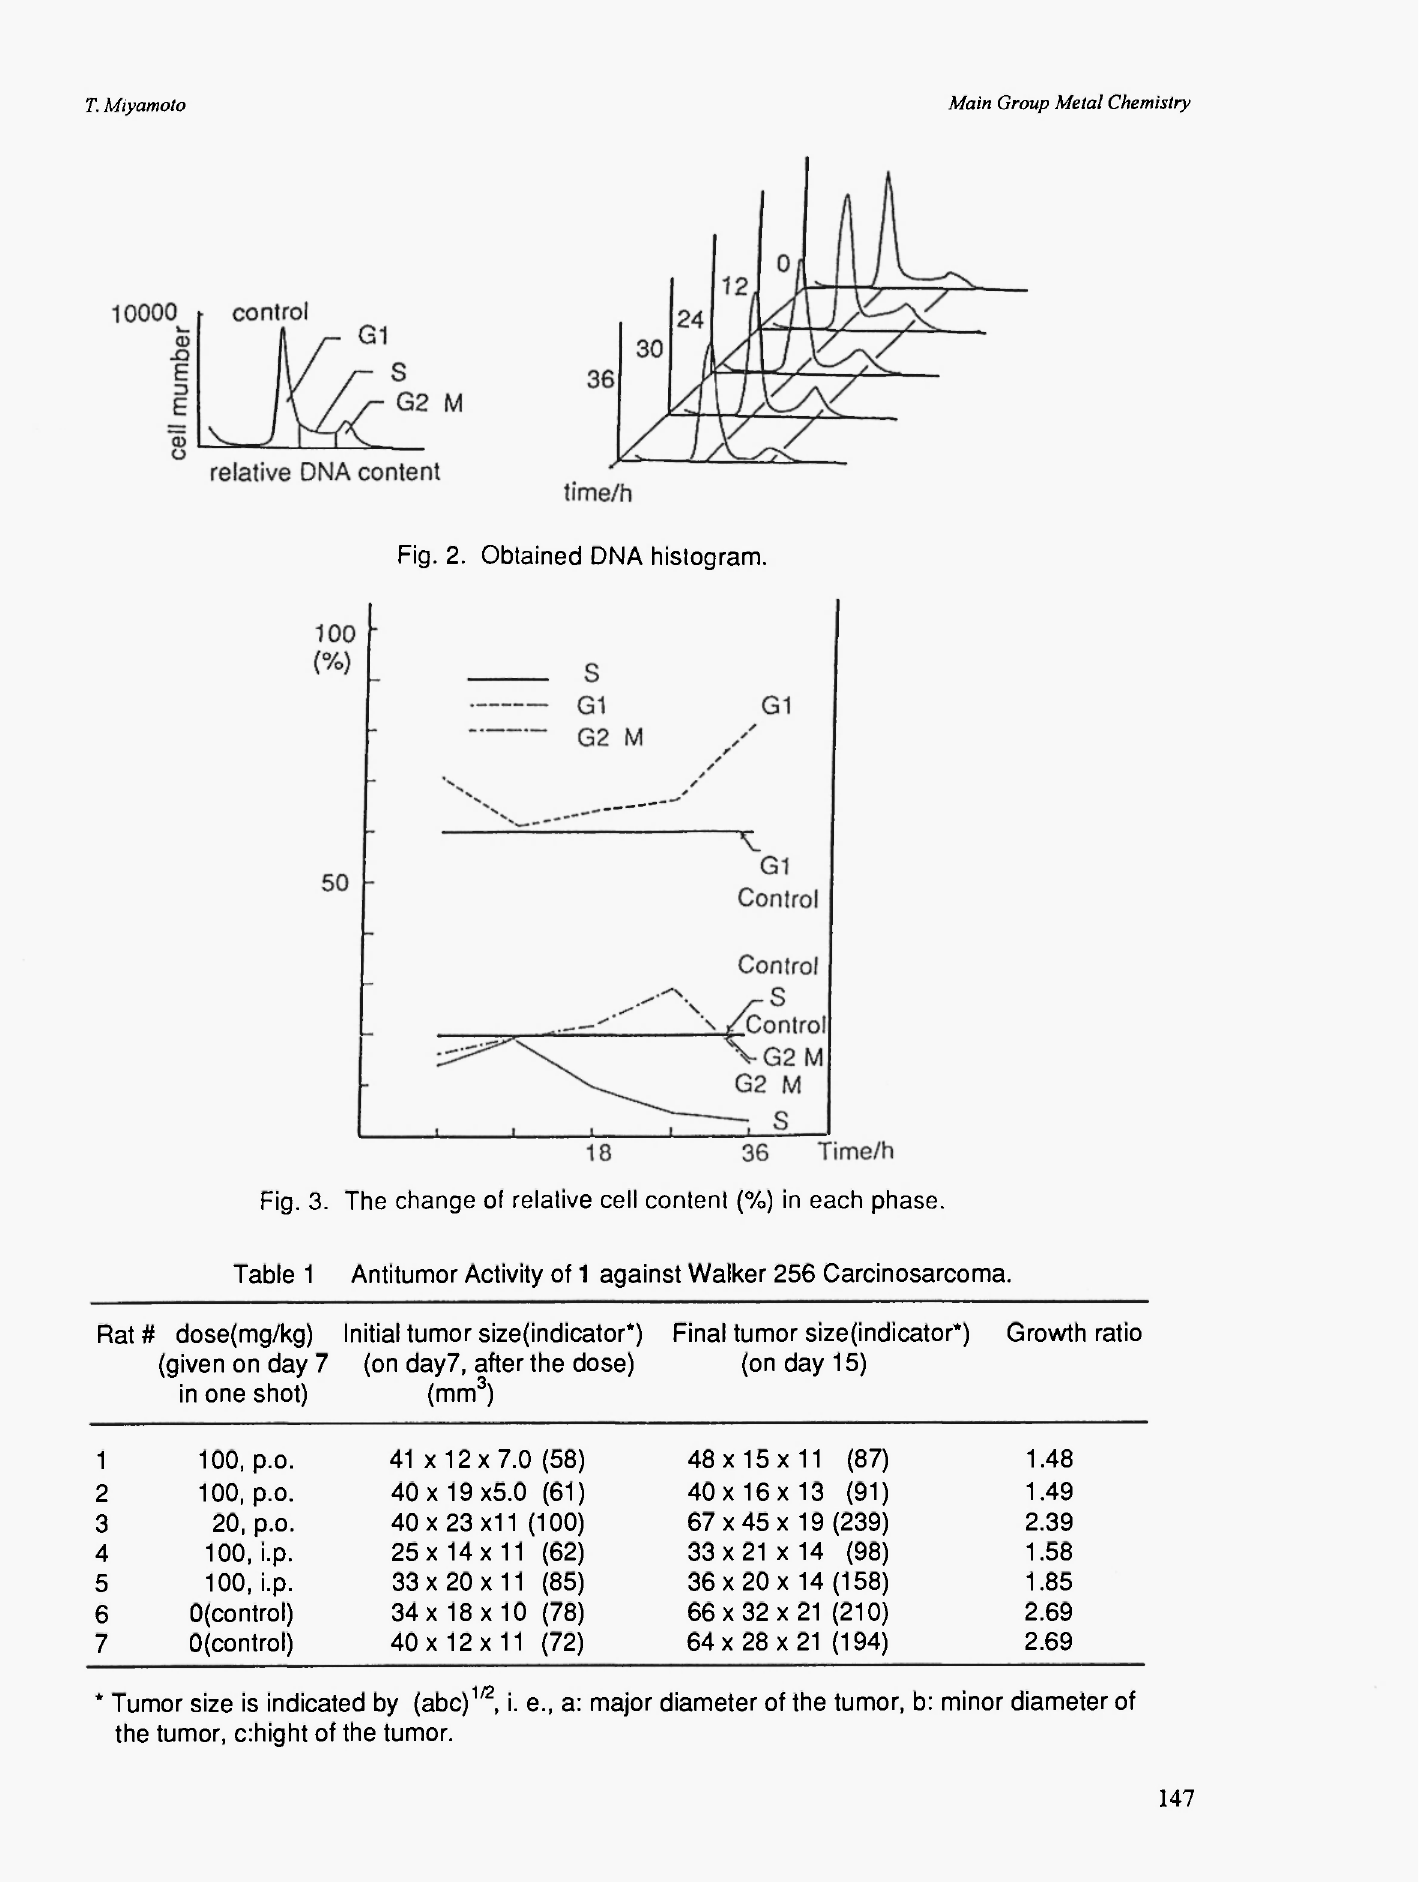
Fig. 2. Obtained DNA histogram.